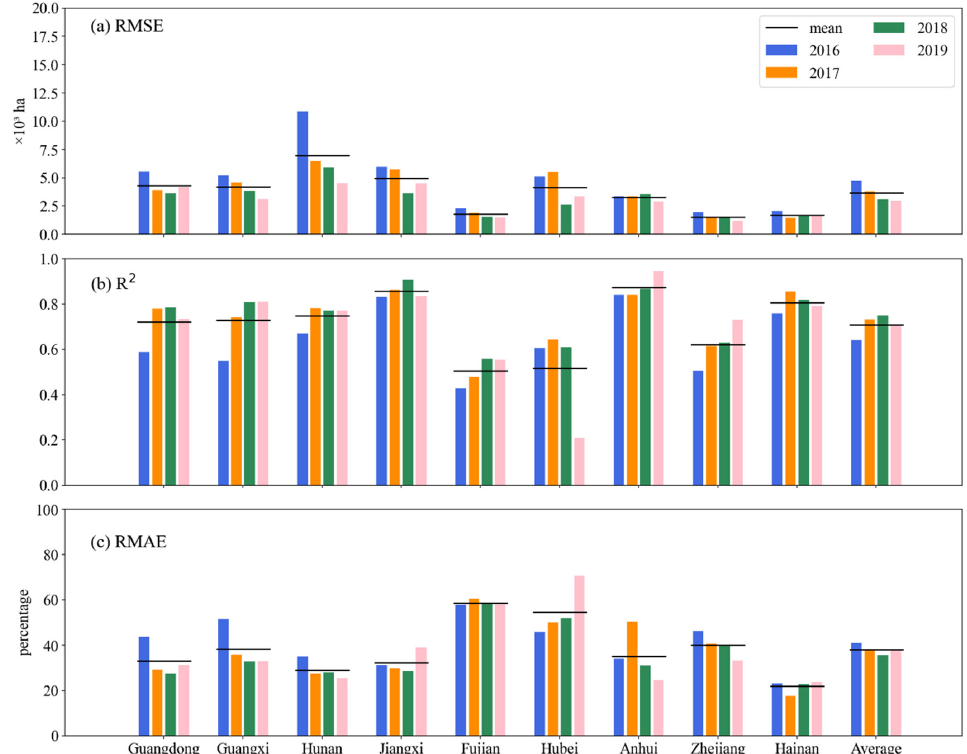
Figure 7. The comparison between identified planting areas of early rice and agricultural census areas at county-level for 2016–2019 in all nine investigated provinces.